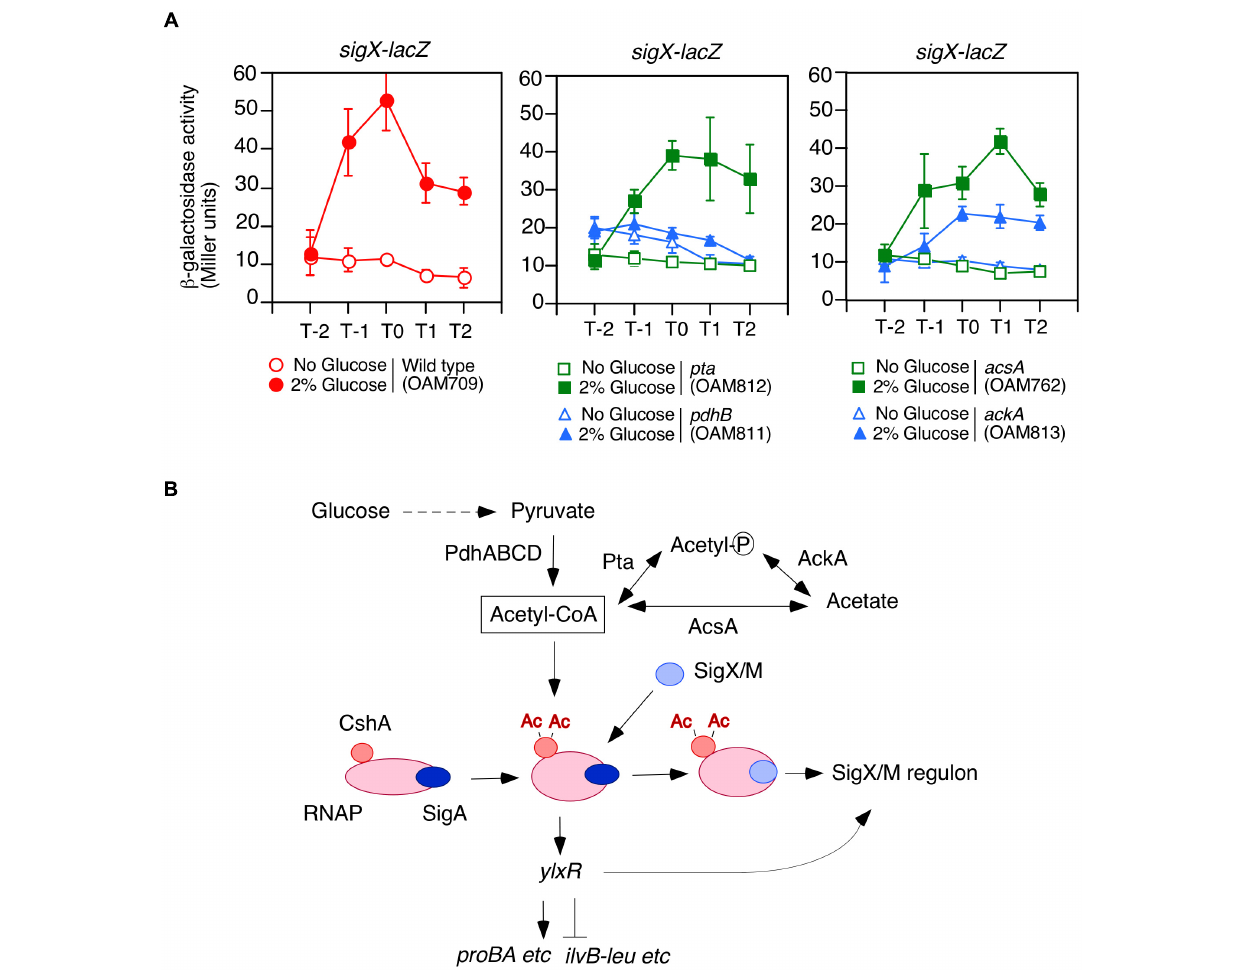
FIGURE 1 | Requirement of acetyl-CoA produced by PDHc for GI of sigX-lacZ . (A) Expression of sigX-lacZ in the mutants. Means of the β -Gal activities from three independent experiments and the standard deviations are shown. The x axis represents the growth time in hours relative to the end of vegetative growth (T0). All strains are the derivatives of wild-type OAM709 and the relevant genotype is indicated below the panel. (B) Model of GI of sigX / sigM and acetyl-CoA metabolism. Glucose addition stimulates the acetylation of CshA (Ogura and Asai, 2016). CshA has been shown to associate with RNAP. RNAP with acetylated CshA may stimulate the replacement of σ X / M for σ A in the RNAP holoenzyme. σ A -associated RNAP holoenzyme with acetylated CshA stimulate the transcription of ylxR (Ogura and Kanesaki, 2018). YlxR regulates many genes and changes the cellular metabolic state, which may lead to induction of the SigX/M regulons. Ac, acetyl moiety; PdhABCD, pyruvate dehydrogenase (PDH); Pta, phosphotransacetylase; AcsA, acetyl-CoA syntheatse; AckA, acetate kinase. “P” in the circle indicates phosphate